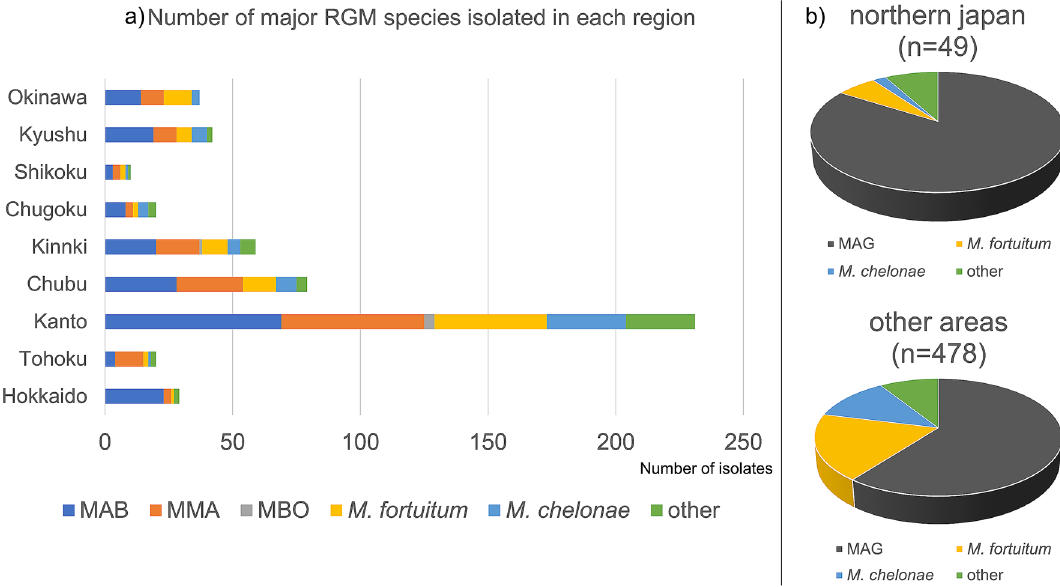
Figure 2. Major rapidly growing mycobacteria species isolated in each region of Japan. Strains isolated from both lower respiratory specimens (LRS) and non-lower respiratory specimens (NLRS) are included. ( a ) Each region of Japan; ( b ) North of Japan (Hokkaido and Tohoku) and other